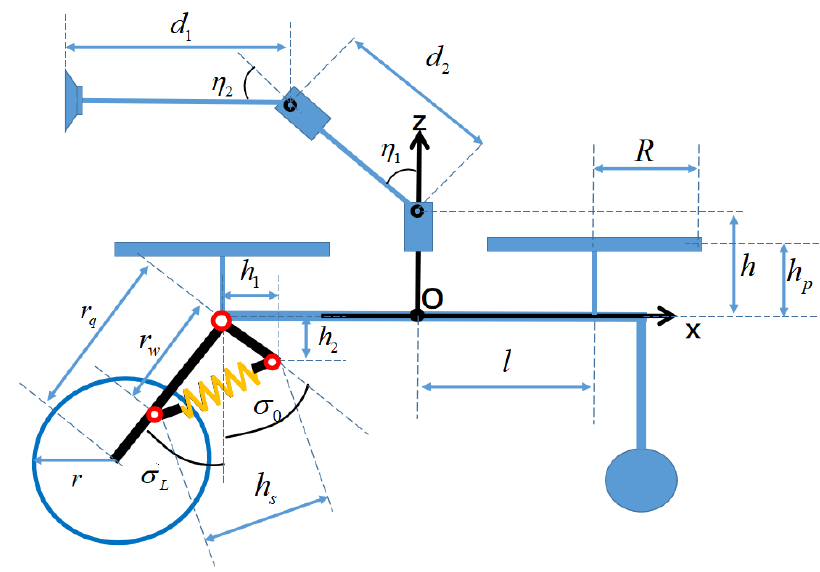
Figure 5. Diagram of the spring mechanism installed on the front wheels. The red circles represent rotating shaft, orange device is the shock absorber.